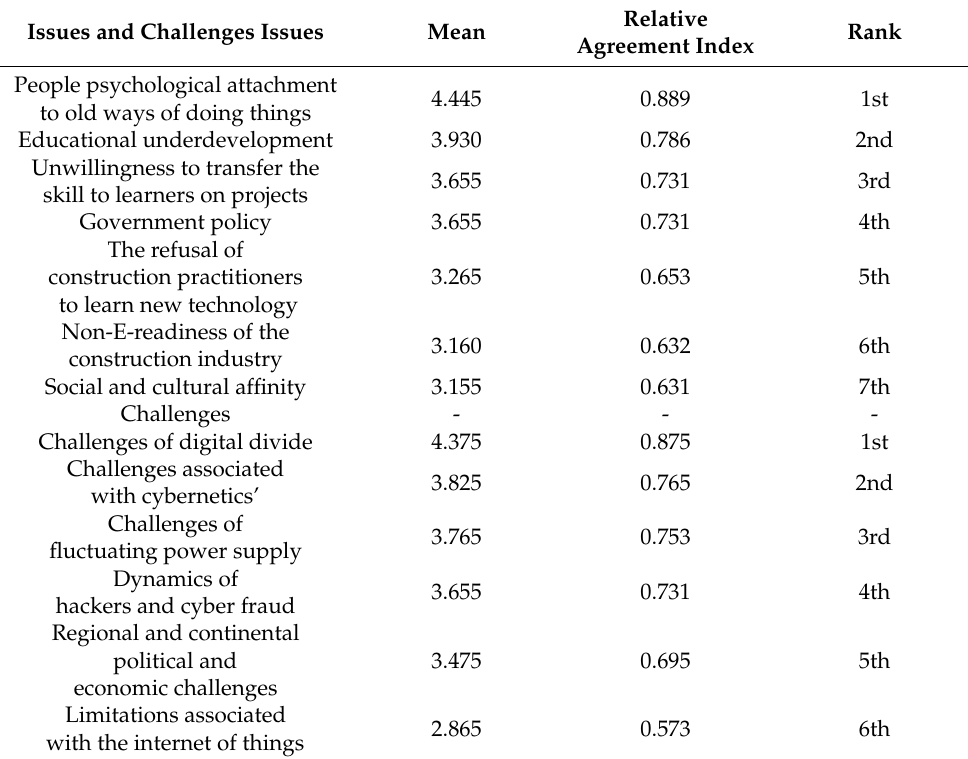
Table 10. Issues and Challenges Involved in Achieving Sustainable Innovation in Infrastructural